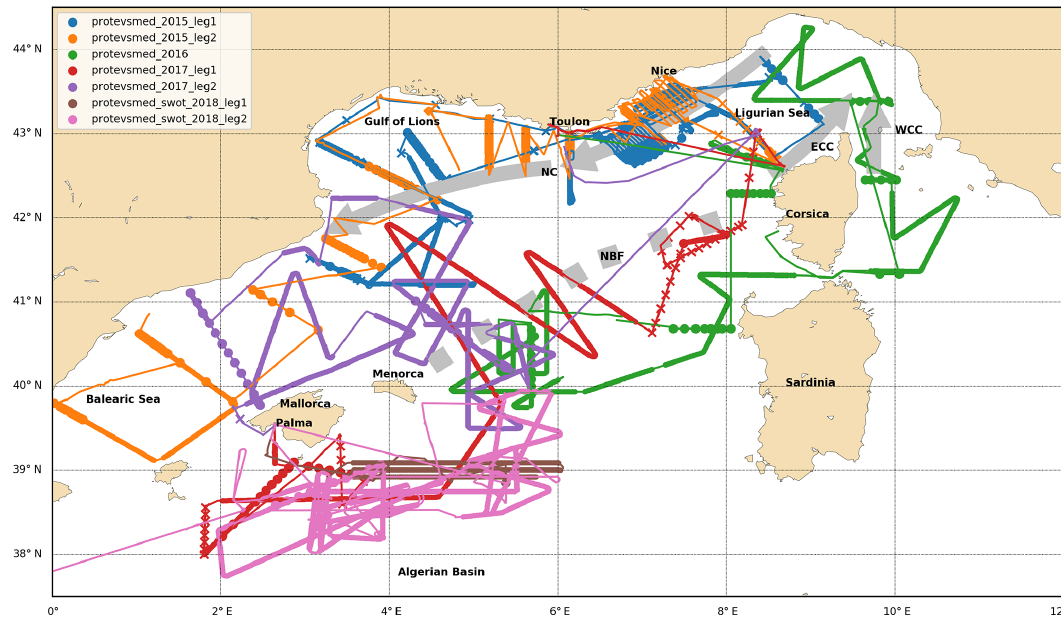
Figure 1. Map of PROTEVS-MED cruises. Dynamical features, northern Balearic front (NBF), eastern Corsica current (ECC), western Corsica current (WCC) and Northern Current (NC) are depicted in